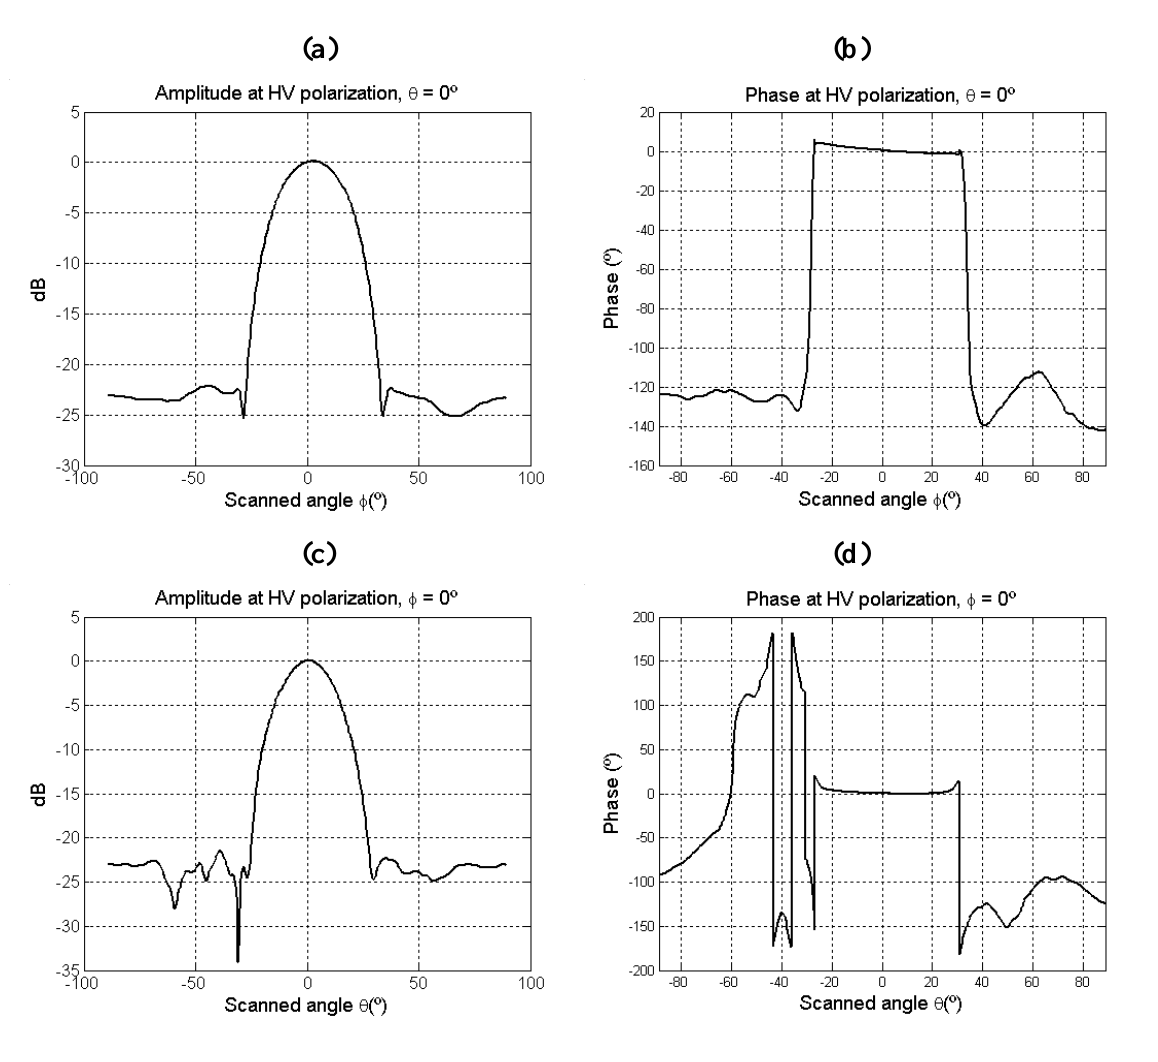
Figure 19. PAU-RAD DBF results in dB for the 0° steered beam and HV polarization, (a) modulus of the beam scanning on the φ domain (non-steerable); (b) phase of the beam on the φ domain; (c) modulus of the beam scanning on the θ domain (steerable); (d) phase of the beam scanning on the θ domain